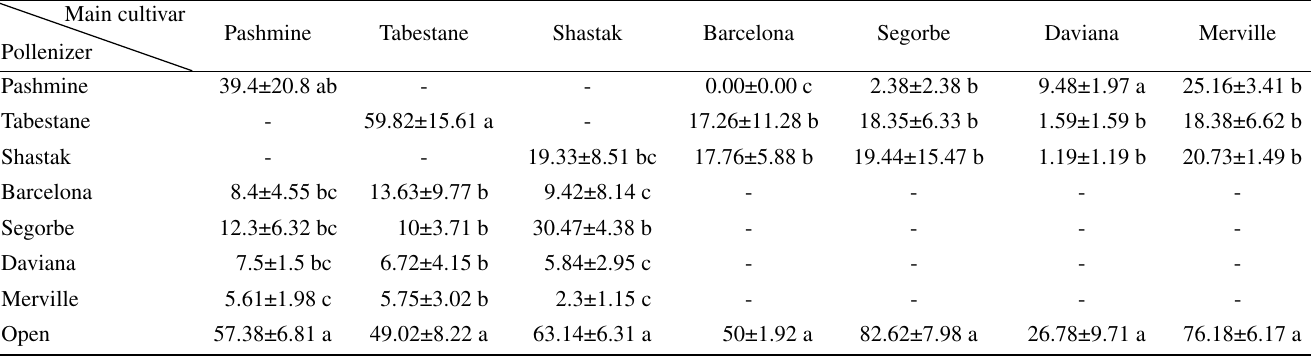
Table 1 - Cluster set in controlled self- and cross-pollinations of some hazelnut cultivars (%) Main